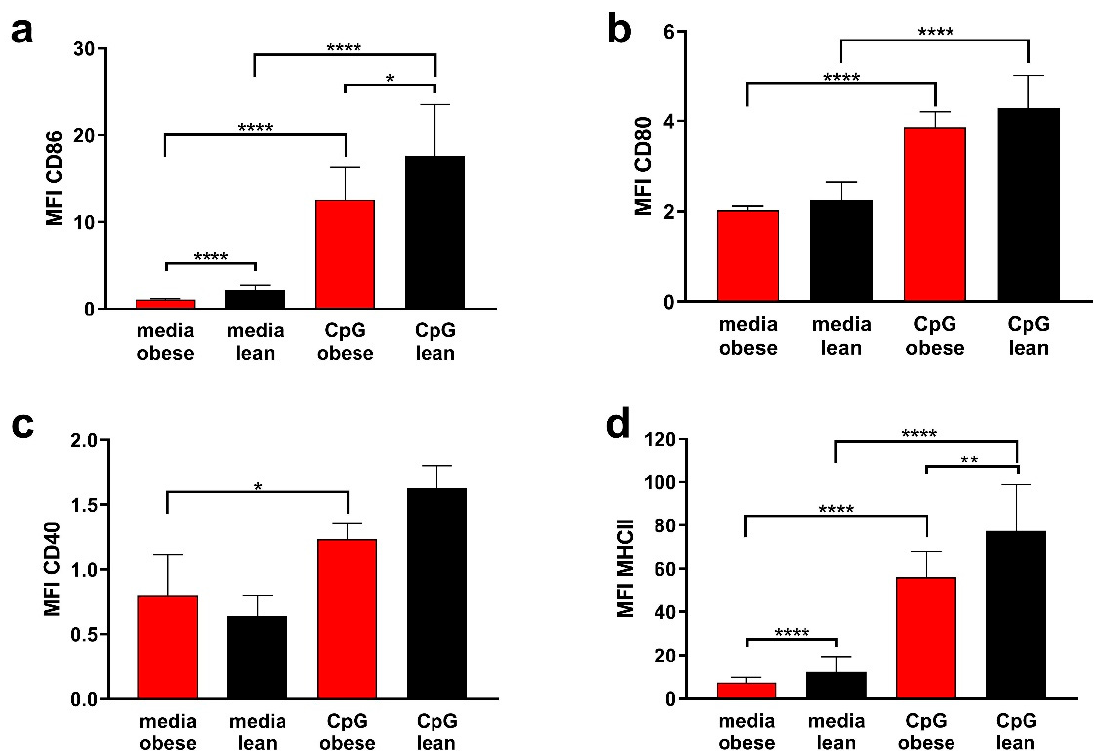
Figure 2. BMDCs generated from the bone marrow of obese and lean mice differ in the expression of activation markers ( a ) CD86 and ( d ) MHCII after stimulation with the vaccine adjuvant CpG. Expression of activation markers ( b ) CD80 and ( c ) CD40 was increased after CpG stimulation but not significantly different between obese and lean mice. BMDCs were generated from the bone marrow of either obese or lean mice with GM-CSF (20 ng/mL) for six days. BMDCs were either left untreated or stimulated with CpG (0.25 µ M) for 24 h and expression of activation markers analysed by flow cytometry. MFI of live CD11c + cells is shown. The results are the mean + STD of 3 independent experiments performed in triplicate, with a total number of 3 mice/model. Statistical significance was determined using a One-way ANOVA test followed by Tueky’s multiple pairwise comparison. * p < 0.05, ** p < 0.01, **** p < 0.0001.